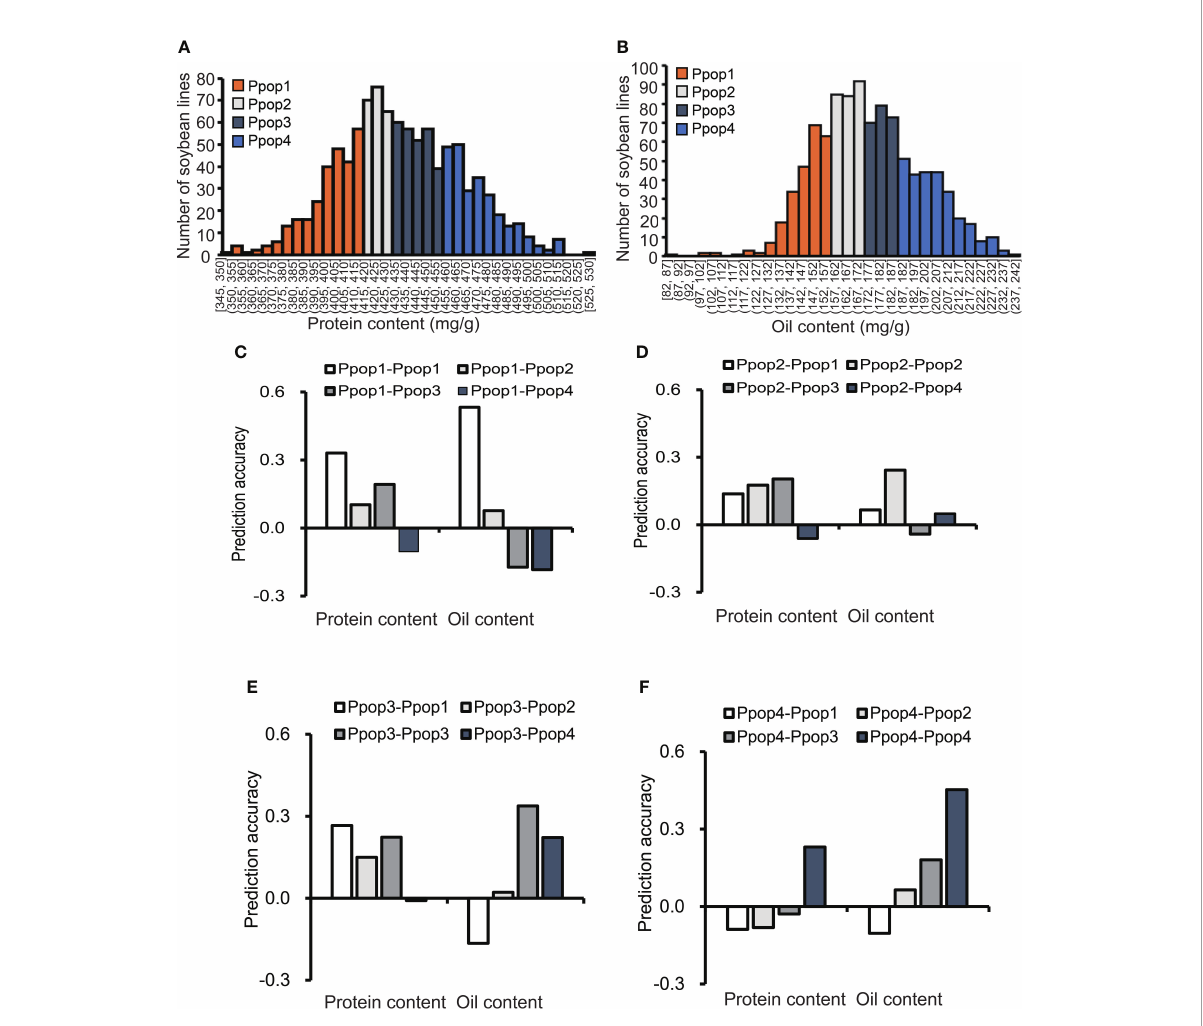
FIGURE 2 The in fl uence of the phenotypic similarity between the training population and prediction population on prediction accuracy. The prediction accuracies of RR-BLUP for protein and oil content (C – F) among soybean germplasms grown at Urbana, IL in 2001 and 2002, when the training population and prediction population were selected based on phenotype (A, B)